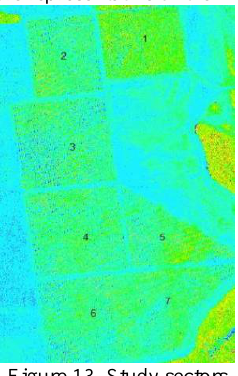
Figure 13. Study sectors